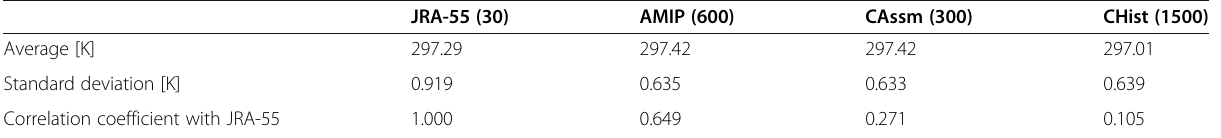
Table 2 Averages and standard deviations of SAT JP for August 1981 – 2010 and correlation coefficients of SAT JP with JRA-55 for August over the 30 years. Numbers in parentheses represent the number of samples for the 30